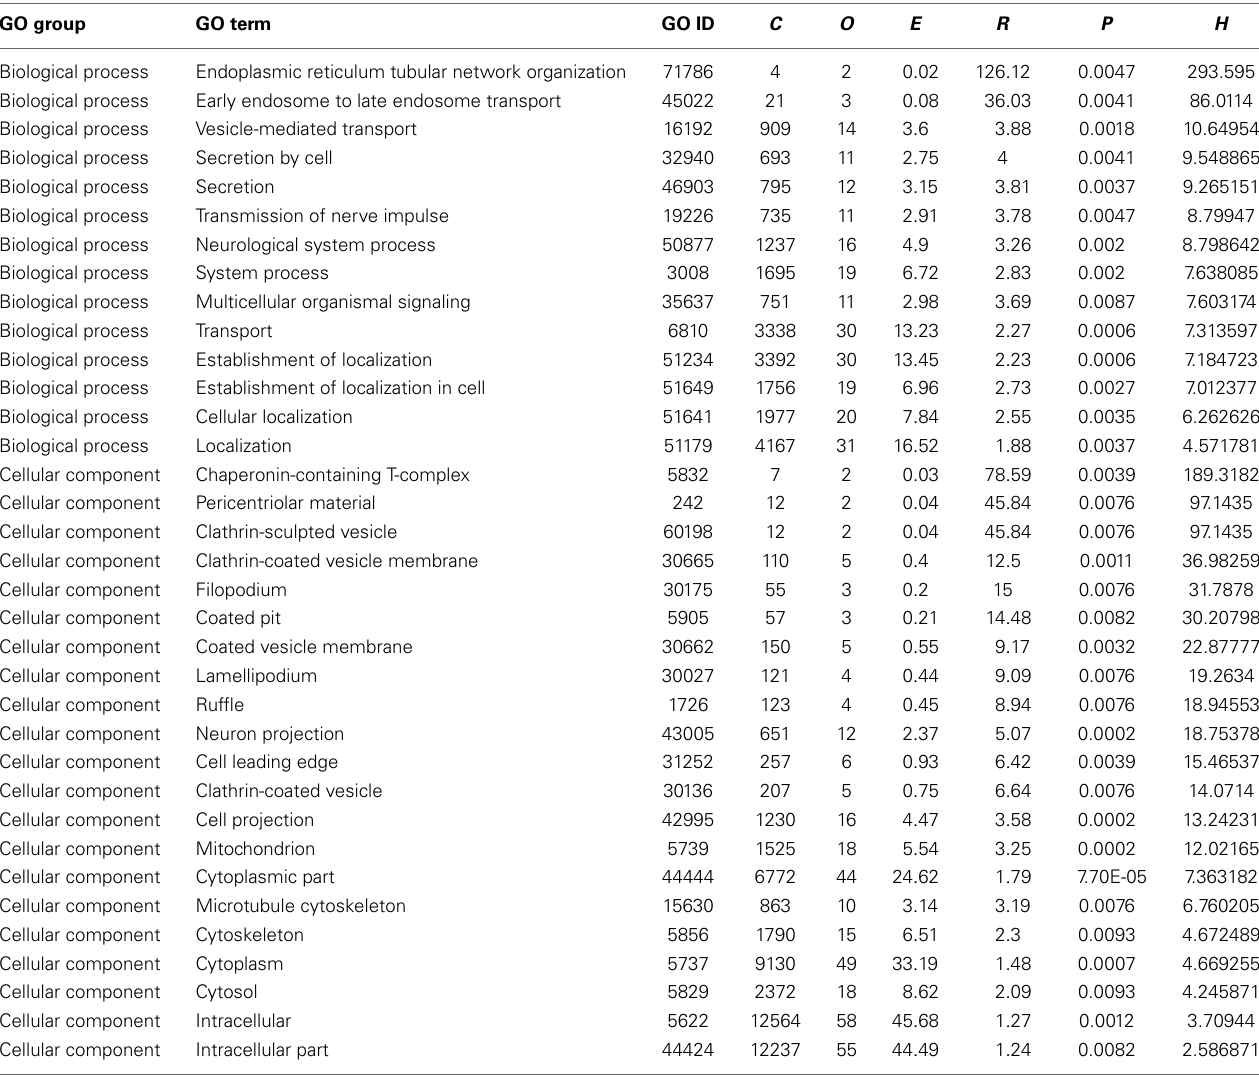
Table 1 | GO term analysis for cortical protein alterations observed in aged BTBR compared to WT